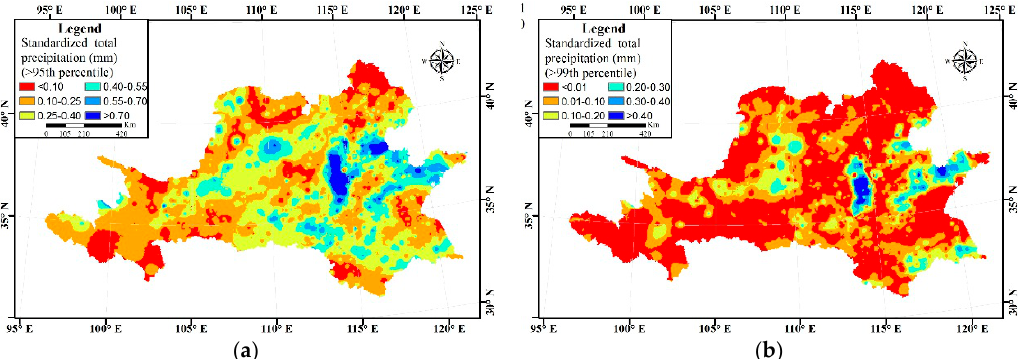
Figure 10. The standardized extreme precipitation accumulation larger than the 95th percentile and 99th percentile. ( a ) The 95th percentile; ( b ) the 99th percentile.